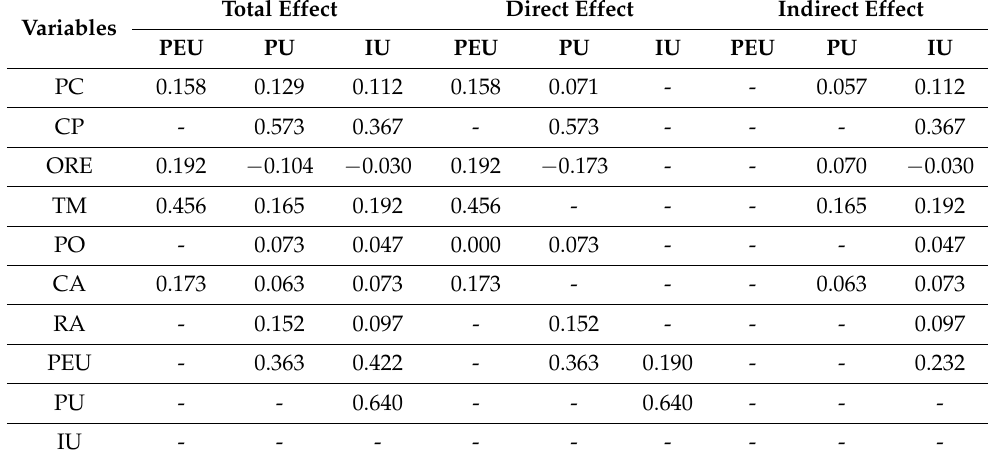
Table 7. Summary of impact